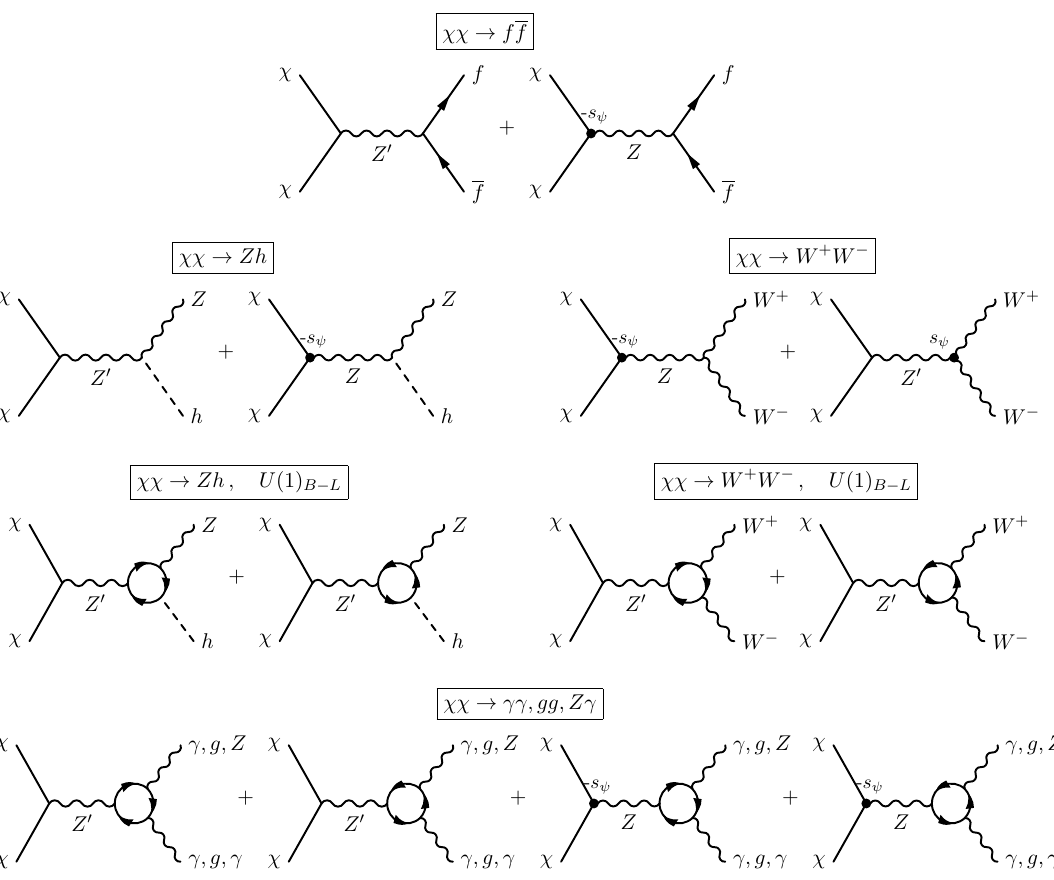
Figure 8 . ( Replaces (cid:12)gure 9 of the original paper .) Feynman diagrams for the annihilation channels ff , Zh , W + W (cid:0) , (cid:13)(cid:13) , gg , Z(cid:13) . Open